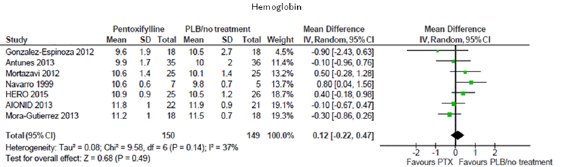
Fig 3. Effects of pentoxifylline vs. placebo/standard treatment on hematocrit.